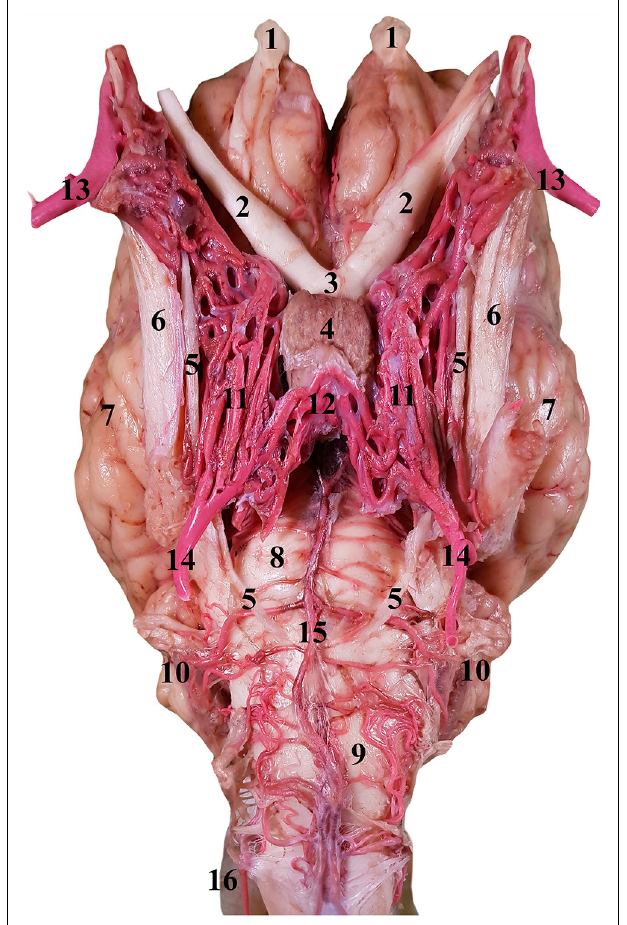
FIGURE 5 | Ventral view of the RERM in the isolated encephalon of the dromedary. 1, Olfactory bulb; 2, optic nerve; 3, optic chiasm; 4, pituitary gland; 5, abducent nerve; 6, trigeminal nerve; 7, left cerebral hemisphere; 8, pons; 9, medulla oblongata; 10, cerebellum; 11, RERM; 12, caudal connection of the rete; 13, maxillary artery; 14, internal carotid artery; 15, basilar artery; and 16, lateral anastomosing branch of the vertebral artery.